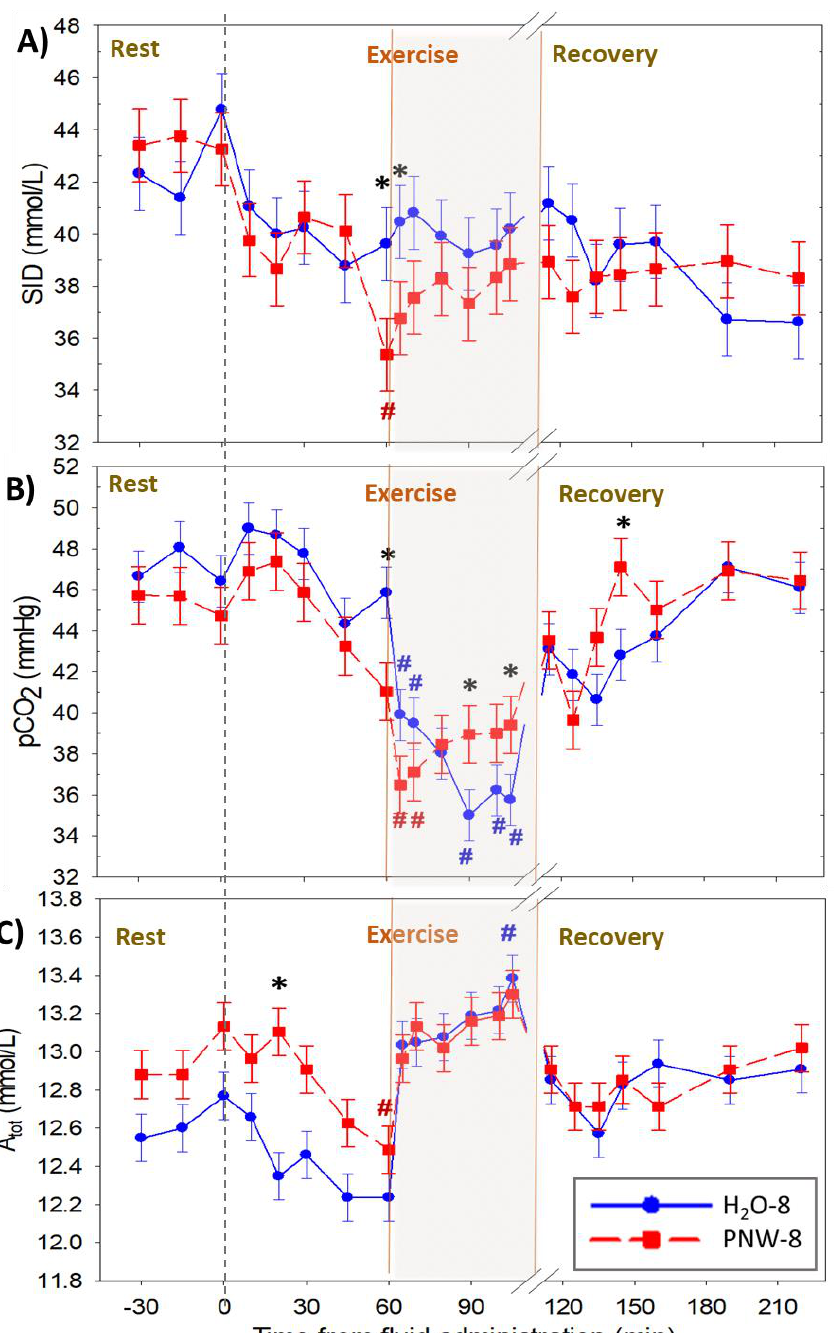
Figure 4. Time course of plasma independent variables at rest during moderate intensity exercise and up to 2 h of recovery. Data show means ± SEM for ( A ) strong ion difference ([SID]), ( B ) partial pressure of carbon dioxide (pCO2) and ( C ) total weak acid concentration ([Atot]) for n = 4 horses. In a randomized crossover design horses were administered wither 8 L of water (control) or a balanced, hypotonic electrolyte solution (PNW-8) 60 min before they exercised on a treadmill at 50% of peak VO2 for 45 min. # and * denote p < 0.05 vs. time 0 and 8L H2O (H2O-8), respectively. Plasma [Na + ] (Figure 5A) and [Cl − ] (Figure 5B) were increased ( p = 0.036 and p < 0.021, respectively) after 8 L of electrolyte supplementation compared to only 8 L of water.